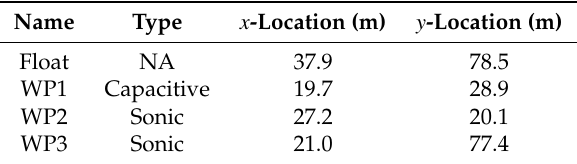
Table 2. Wave sensor locations in MASK